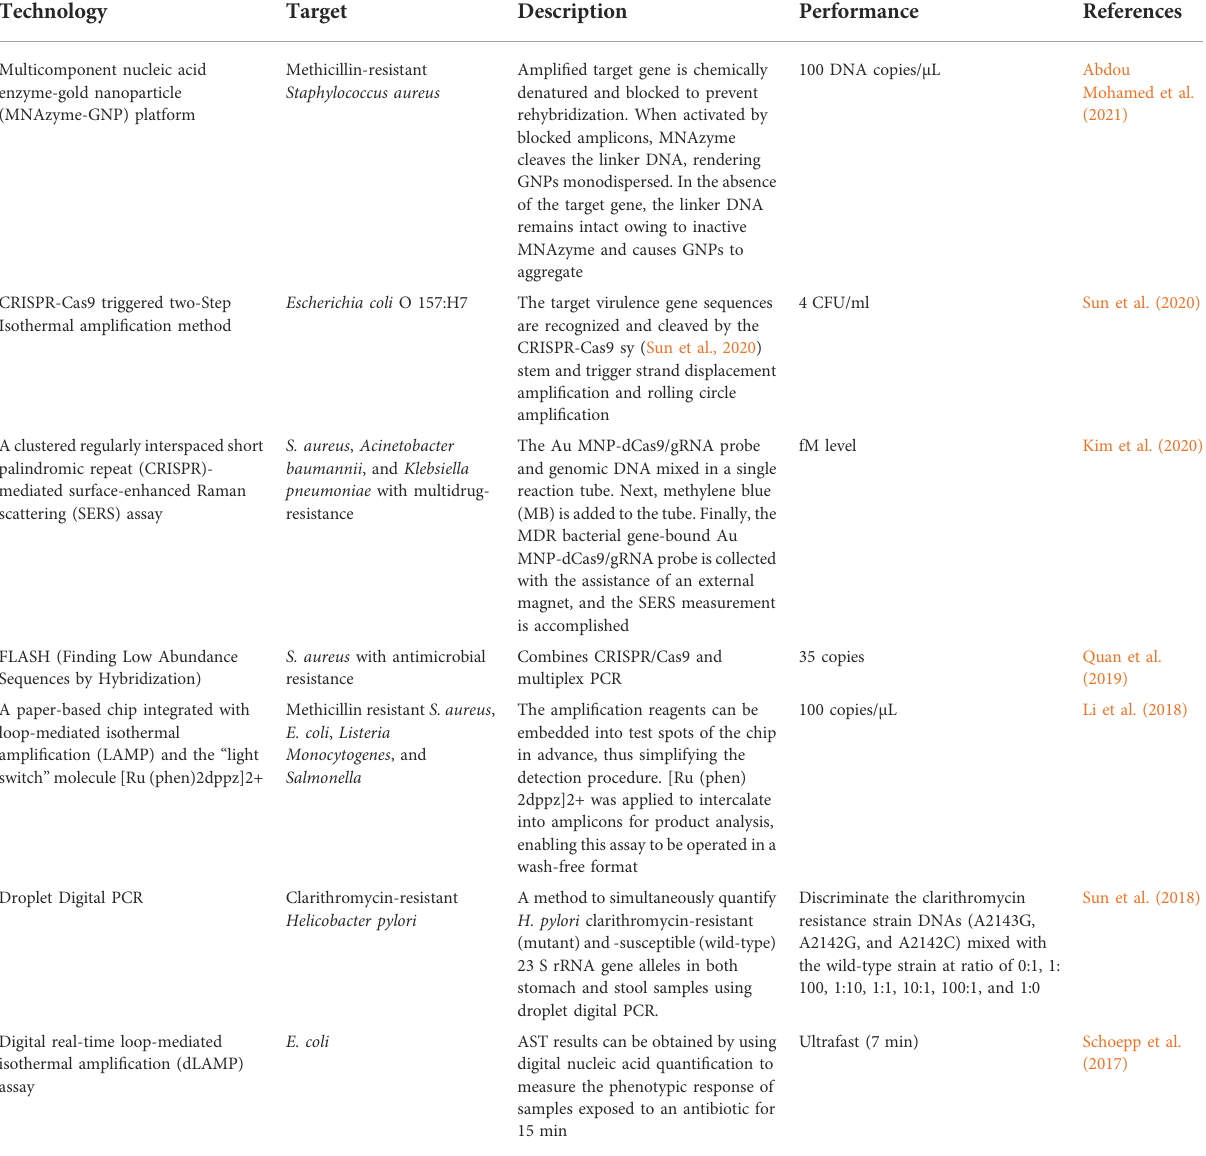
TABLE 2 A brief introduction of different molecular detection